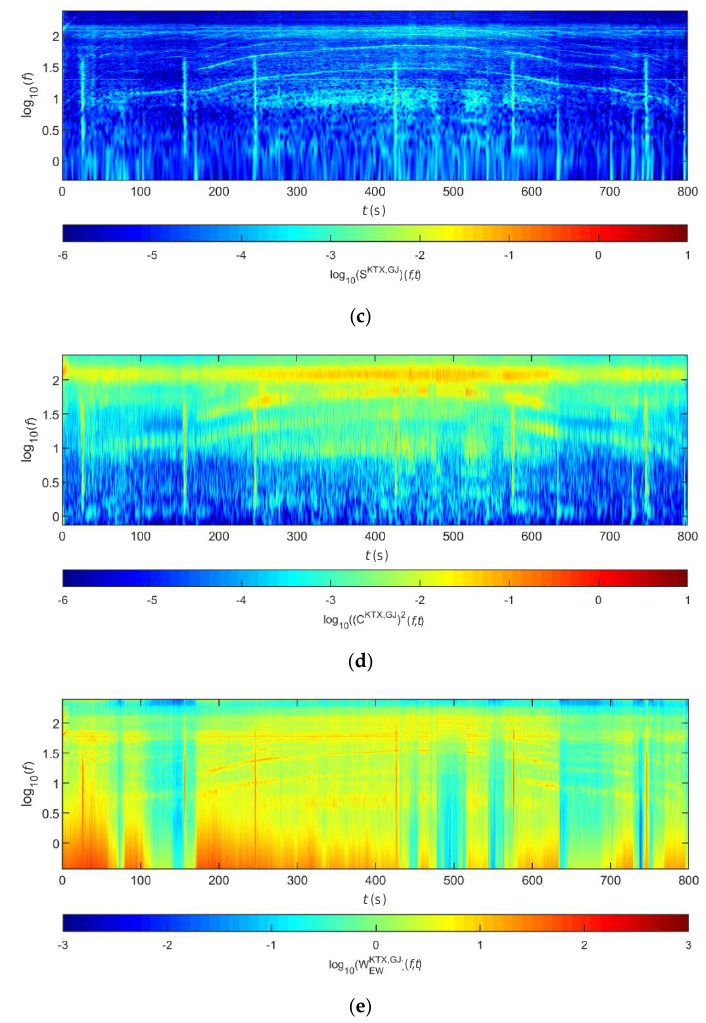
Figure 22. Combination of train data with the Gyeongju earthquake data (scaled to 1000-year return period): ( a ) velocity; ( b ) lateral acceleration time series; ( c ) STFT; ( d ) WT; ( e ) WVD.